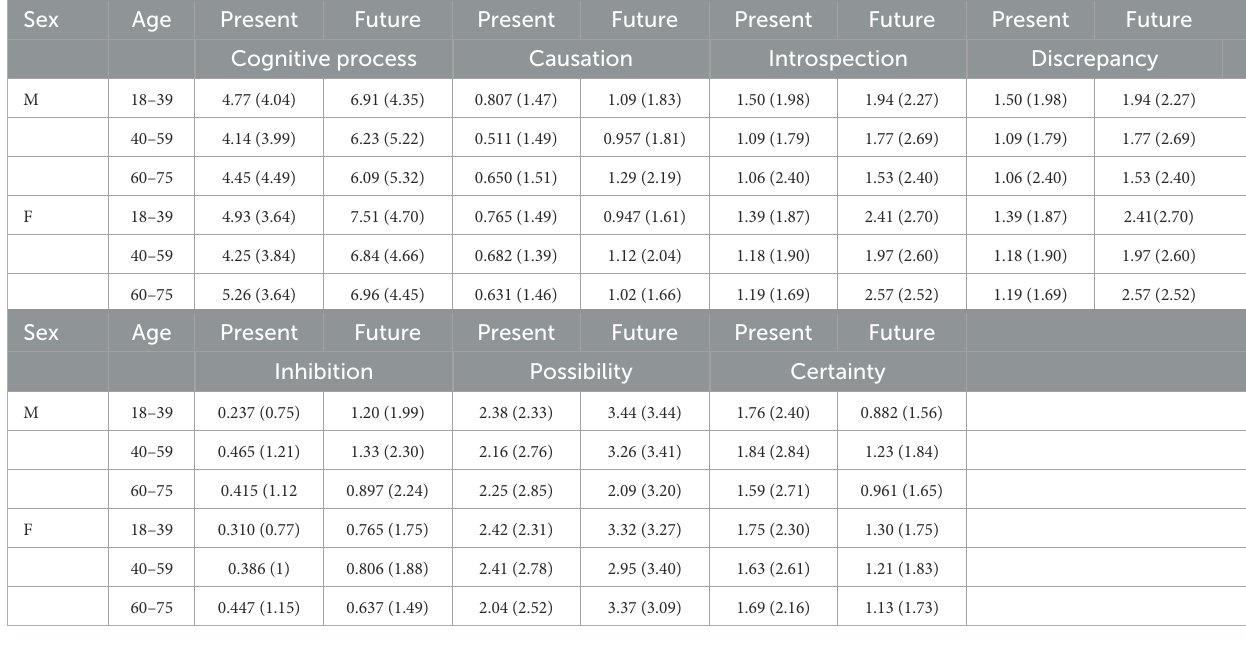
TABLE 5 Descriptive statistics for cognitive features.